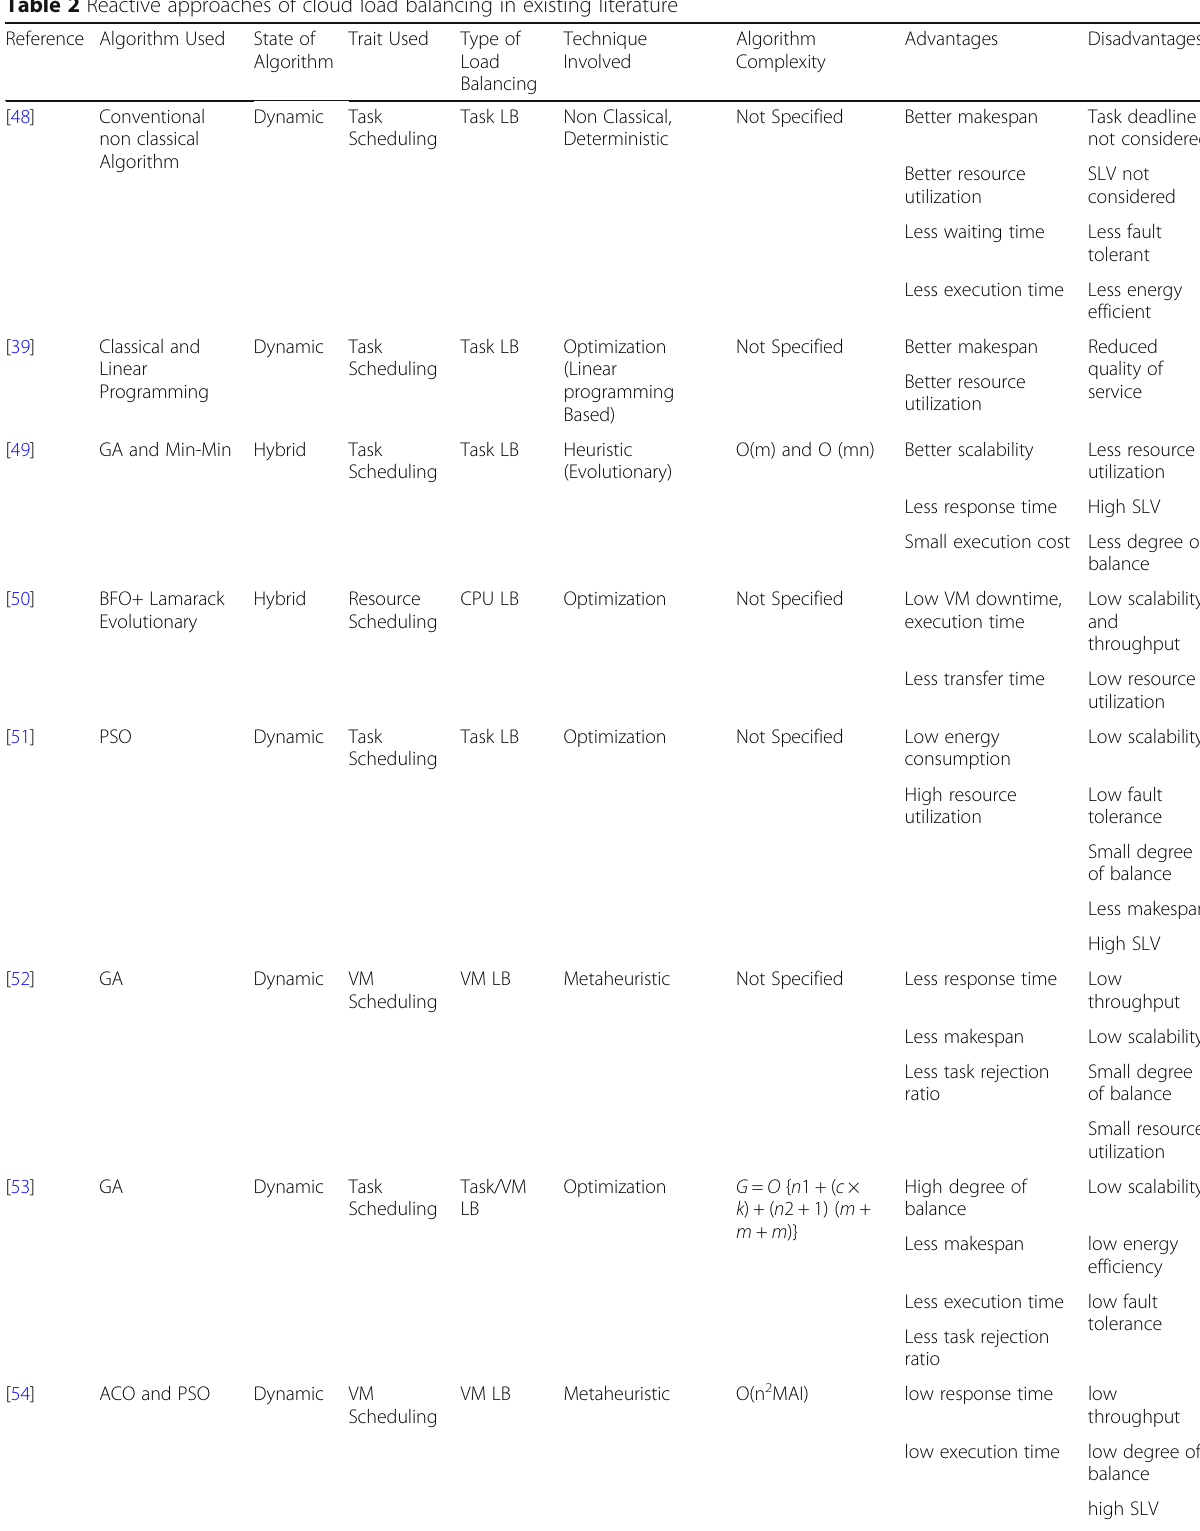
Table 2 Reactive approaches of cloud load balancing in existing literature Reference Algorithm